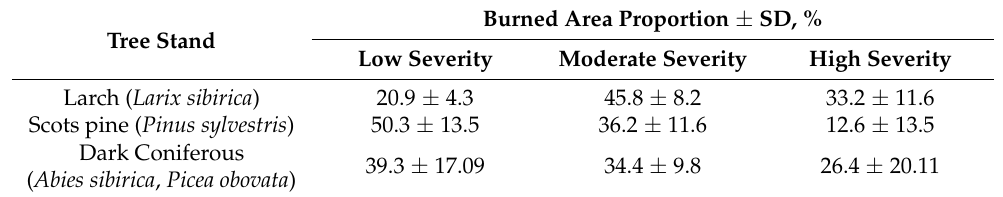
Table 2. Fire area proportion and standard deviation (SD) according to severity/fire impact level from dNBR ranges under the conditions of Siberian forests.